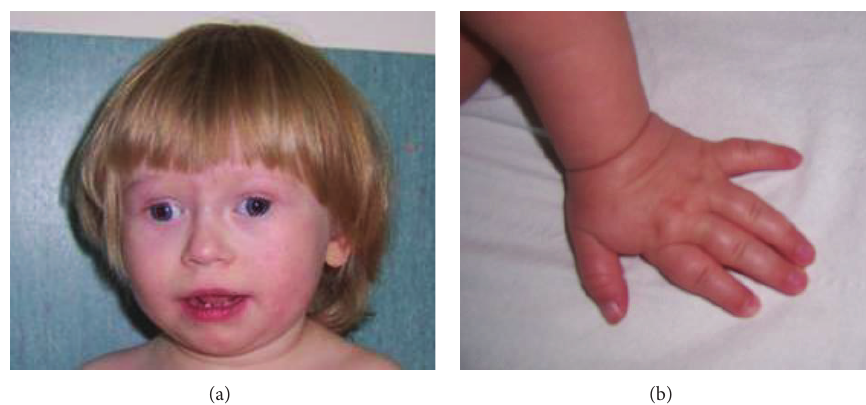
Figure 2: (a) Dysmorphic features of the patient, big exotropia. (b) Fifth finger clinodactyly.